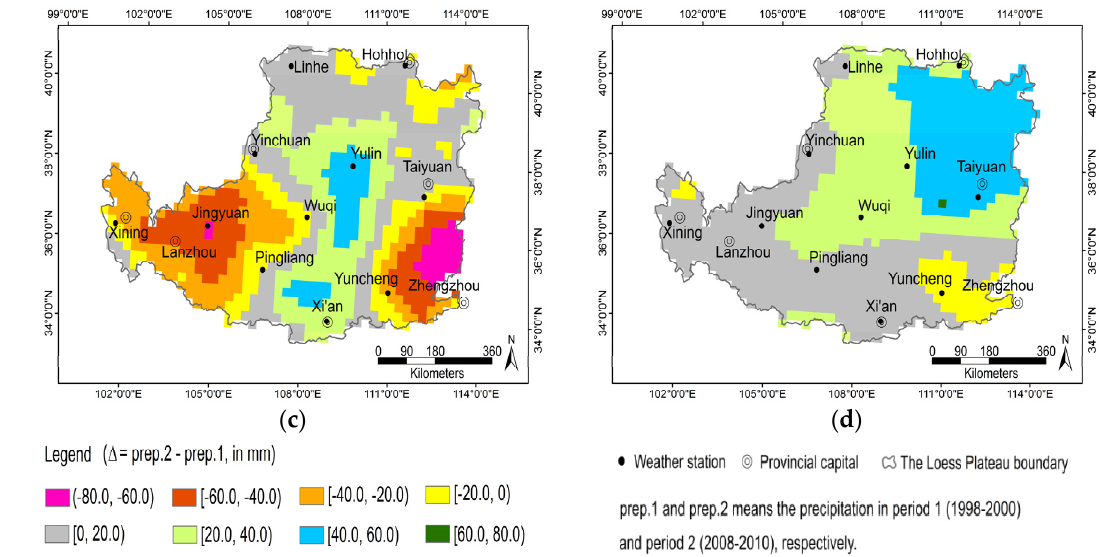
Figure 2. The spatial differences of mean annual precipitation ( a ); the precipitation for the three seasons (spring ( b ); summer ( c ) autumn ( d )) between the two periods on the Loess Plateau.